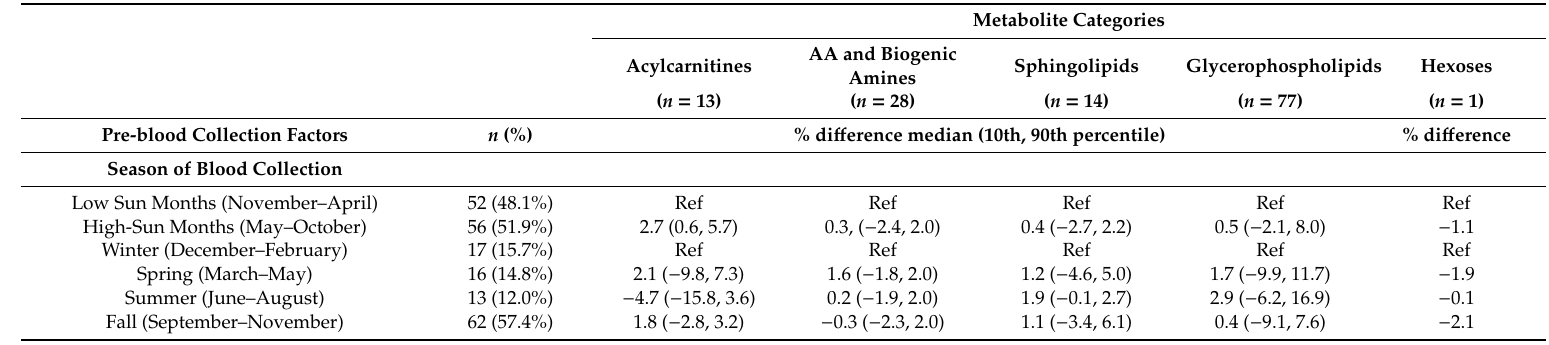
Table 3. Age- and sex-adjusted median (10th percentile, 90th percentile) percentage di ff erences in mean metabolite concentrations by pre-blood collection factors within metabolite class in the PRÄVENT cohort ( n =